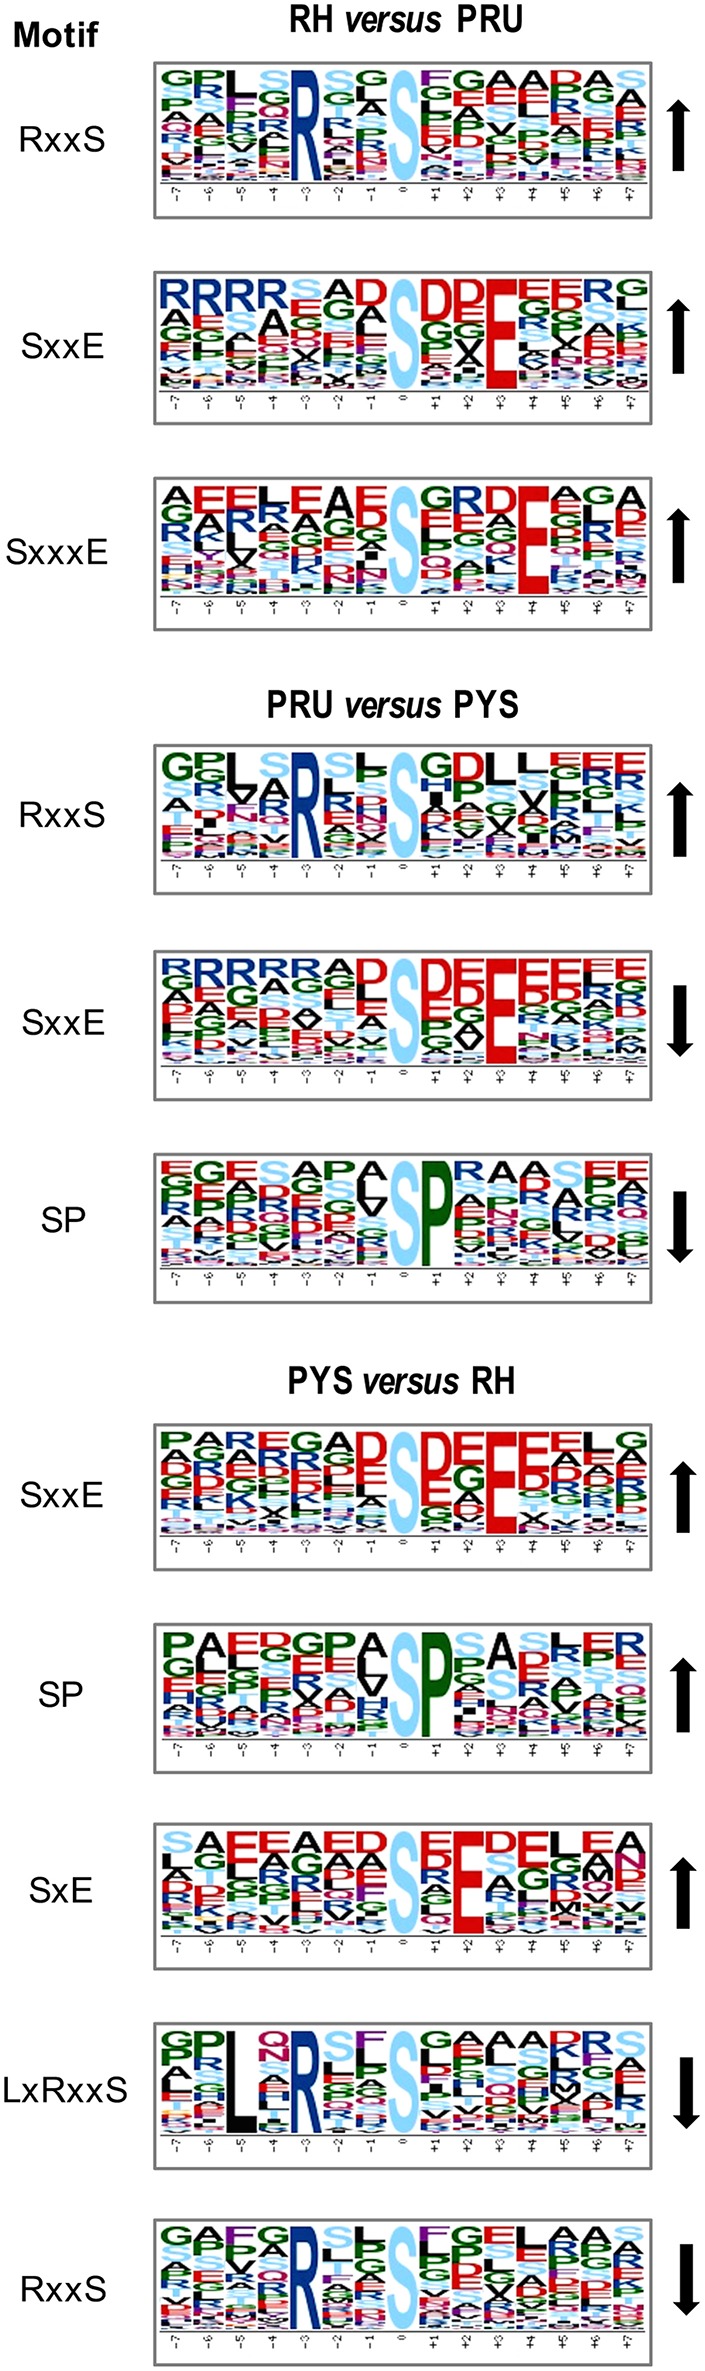
Phosphorylation-specific motif analysis using the Motif-X algorithm. The representations of the serine phosphorylation motifs identified from all unambiguous phosphorylation sites are depicted as sequence logos. The height of the residues represents the frequency with which they occur at the respective positions. The color of the residues represents their physicochemical properties. Arrows pointing up or down on the right of each motif denotes that the motif was up-regulated or down-regulated, respectively.